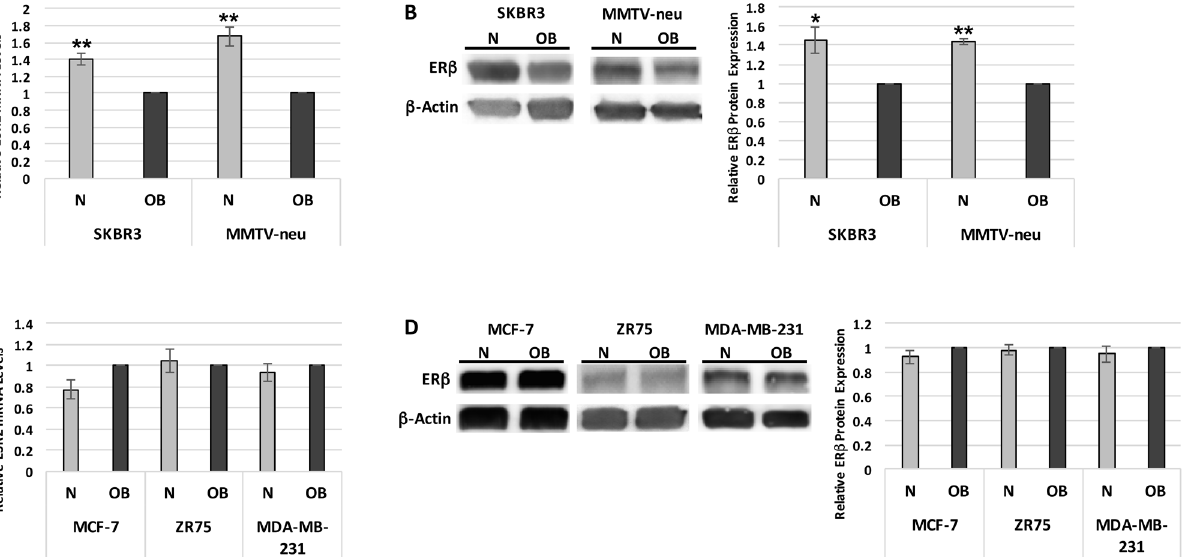
Fig 1. ER β expression is suppressed by obesity-associated systemic factors in HER2-overexpressing breast cancer cells. (A) ESR2 mRNA levels, measured by quantitative RT-PCR, in SKBR3 breast cancer cells and mammary carcinoma cells isolated from MMTV-neu mice following a 1-hour exposure to normal weight (N) or obese (OB) patient sera. (B) ER β protein levels, measured by western blotting, in SKBR3 and MMTV-neu cells following a 2-hour exposure to N or OB patient sera. (C) ESR2 mRNA levels, measured by quantitative RT-PCR, in MCF-7, ZR75, and MDA-MB-231 breast cancer cells following a 1-hour exposure to N or OB patient sera. (D) ER β protein levels, measured by western blotting, in MCF-7, ZR75, and MDA-MB-231 cells following a 2-hour exposure to N or OB patient sera. Data shown represents the average of at least three independent experiments. * , p < 0.05; ** , p < 0.01 relative to OB